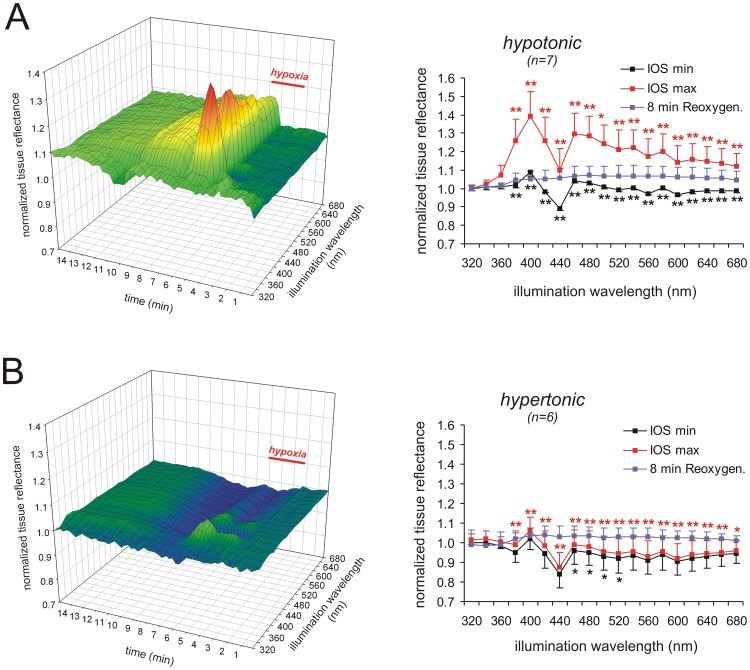
Hypotonicity intensifies whereas hypertonicity attenuates the multispectral IOS. A) Inducing HSD in hypotonic solutions (30 mM NaCl omitted) intensified the multispectral IOS. As indicated by the averaged reflectance profiles, tissue reflectance within almost the entire wavelength range became markedly more intense during HSD. Color-matched asterisks indicate statistically significant changes as compared to the earlier recorded control HSDs (* P<0.05, ** P<0.01). B) In hypertonic solutions (60 mM mannitol added), the multispectral IOS was severely affected. Especially the reflectance increase during HSD was almost abolished.